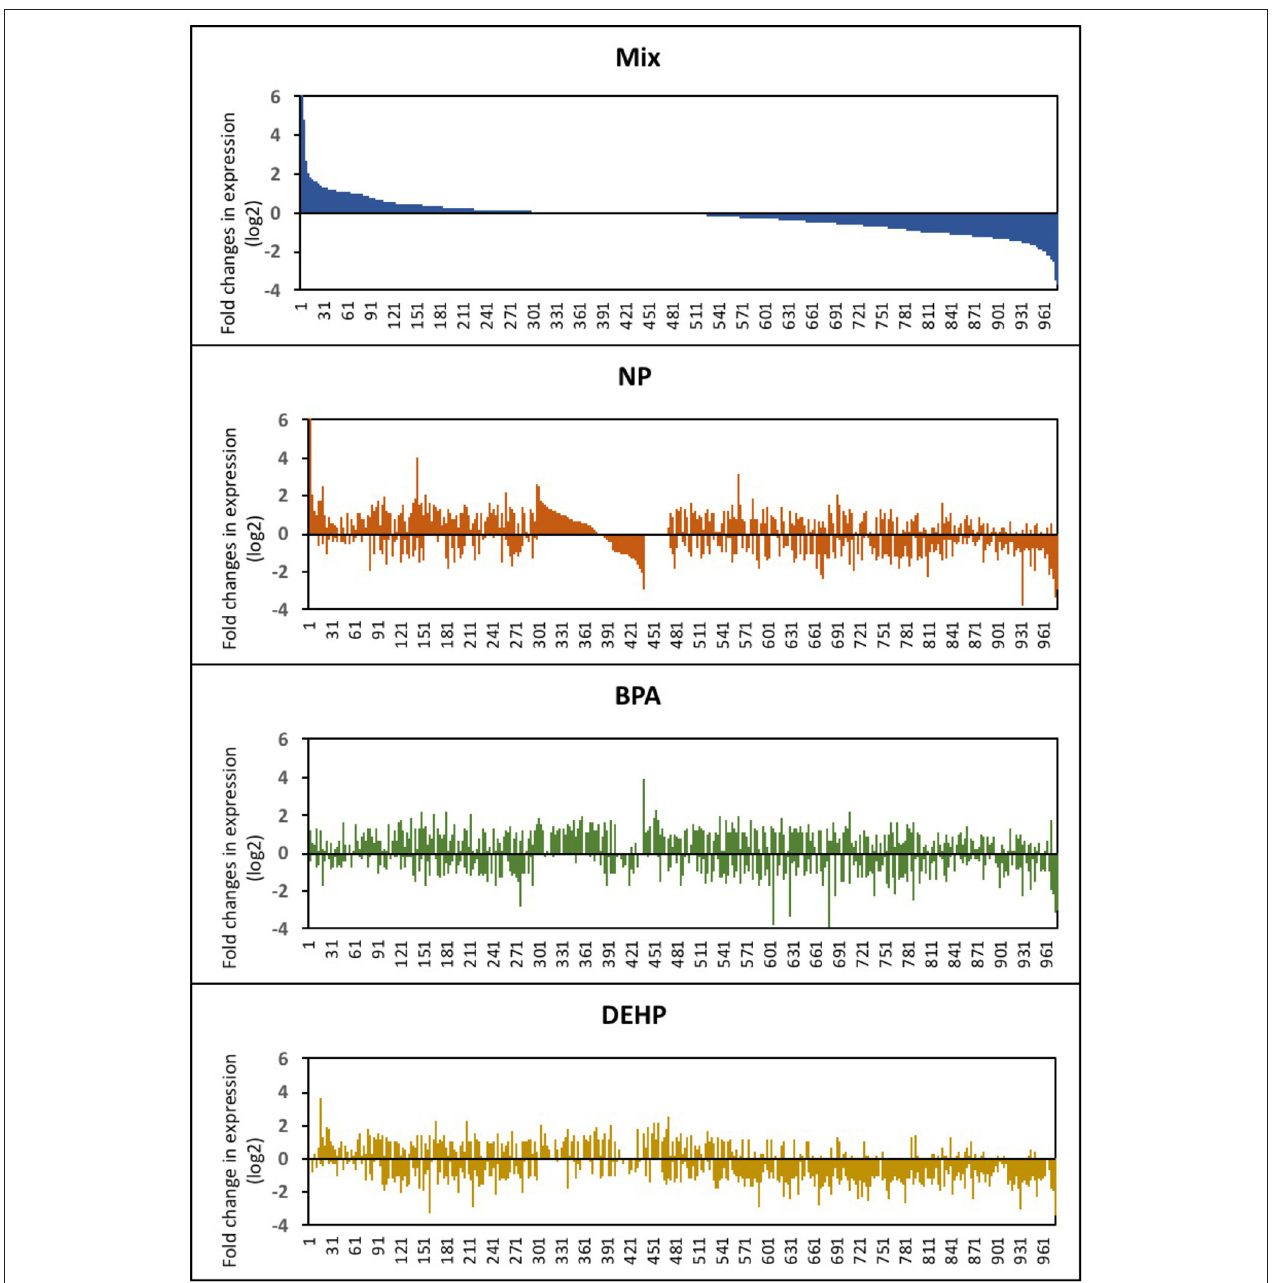
FIGURE 2 | Expression profile of male fathead minnow livers following exposure to NP, BPA, DEHP and the mixture of three compounds. Differentially-expressed genes are shown as the log 2 fold change of expression in EDC-exposed male fish compared to untreated control fish. The gene order in the horizontal axis corresponds to the differential-expressed genes from the EDC mixture is kept consistent for the other three treatments.